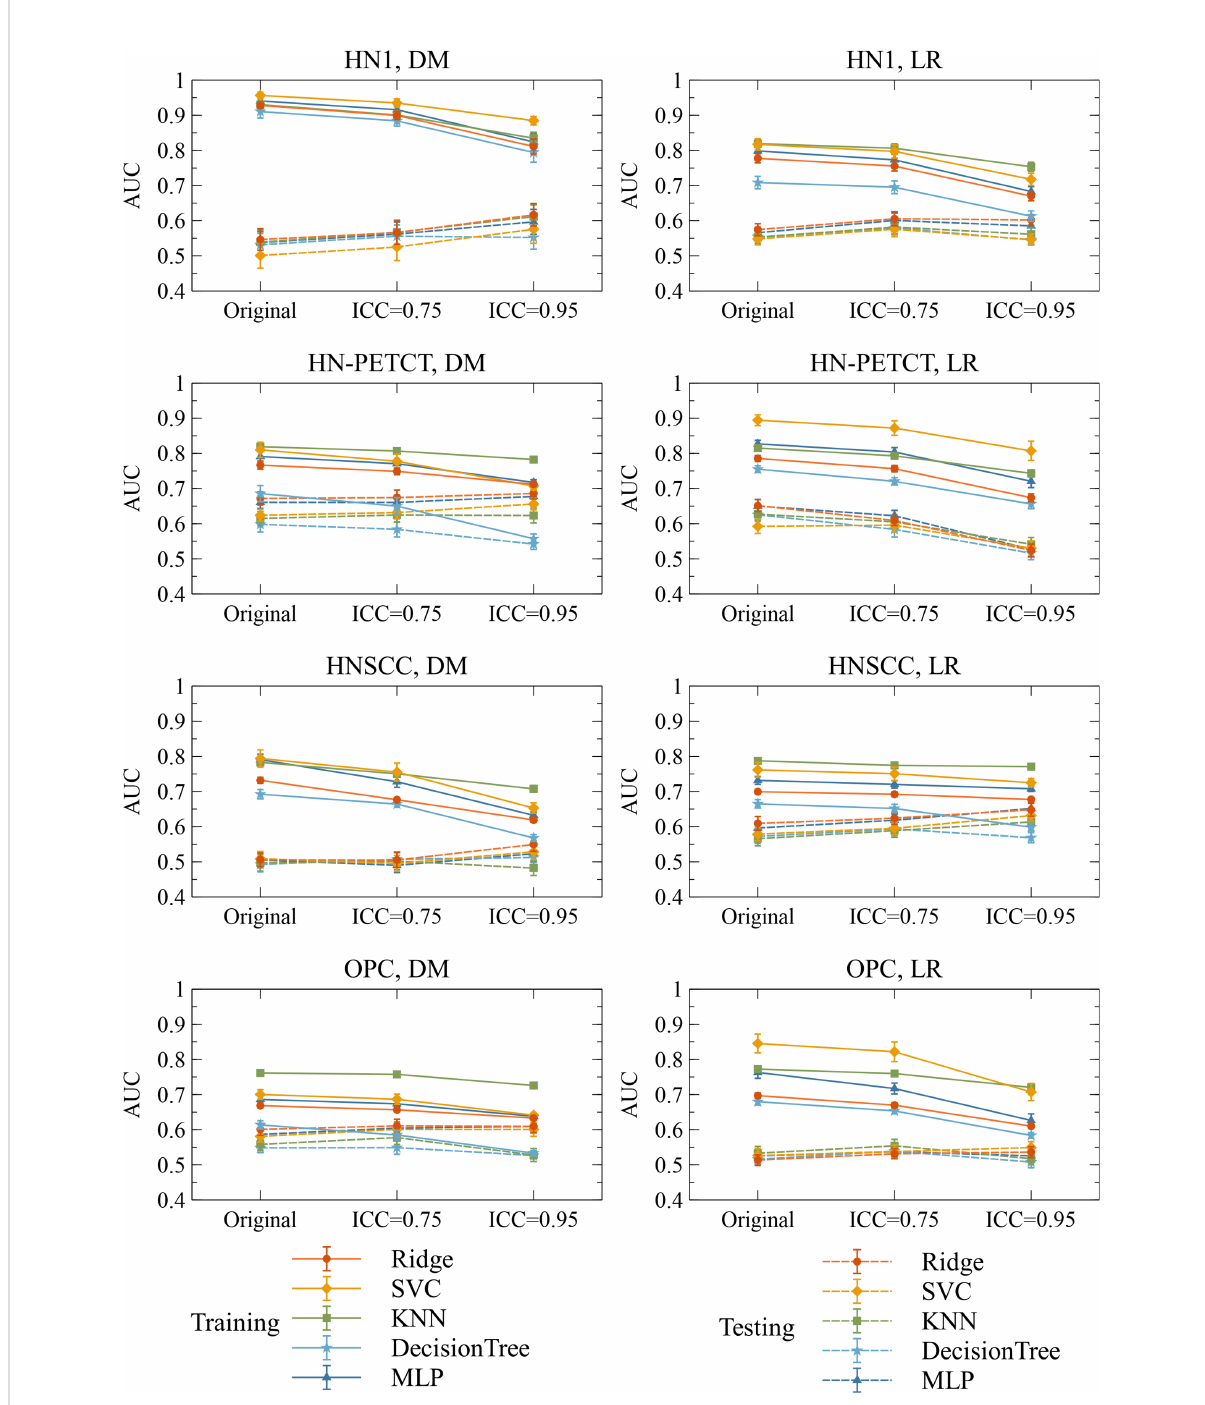
FIGURE 7 The mean and its 95% con fi dence interval of the training and testing AUCs of the fi nal constructed models. Each color represents one classi fi er for modeling. The solid lines represent the training performances, and the dashed lines represent the testing performances. The 95% con fi dence intervals are drawn by the error bars. Each sub fi gure contains the evolution of training/testing AUCs with increasing feature robustness fi ltering thresholds for one dataset and prediction outcome. A decreasing trend of training AUCs were observed with increasing thresholds for all the datasets, prediction outcomes, and classi fi ers. The testing AUCs remain stable except for local-regional recurrence prediction on HN-PETCT